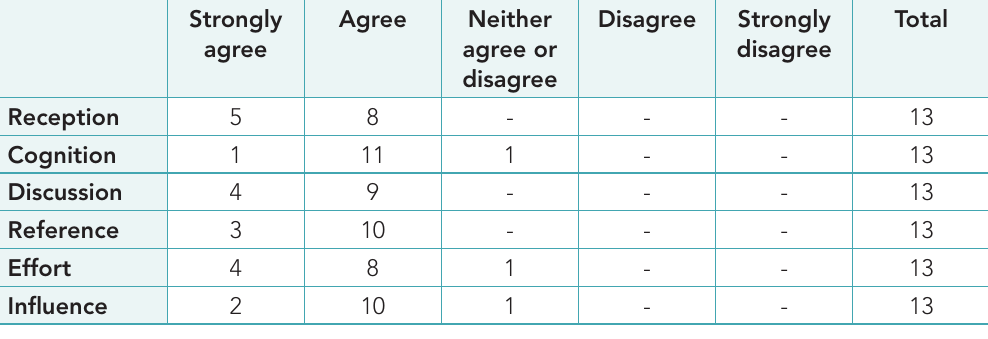
Table 1: Responses to the ‘ladder of research use’